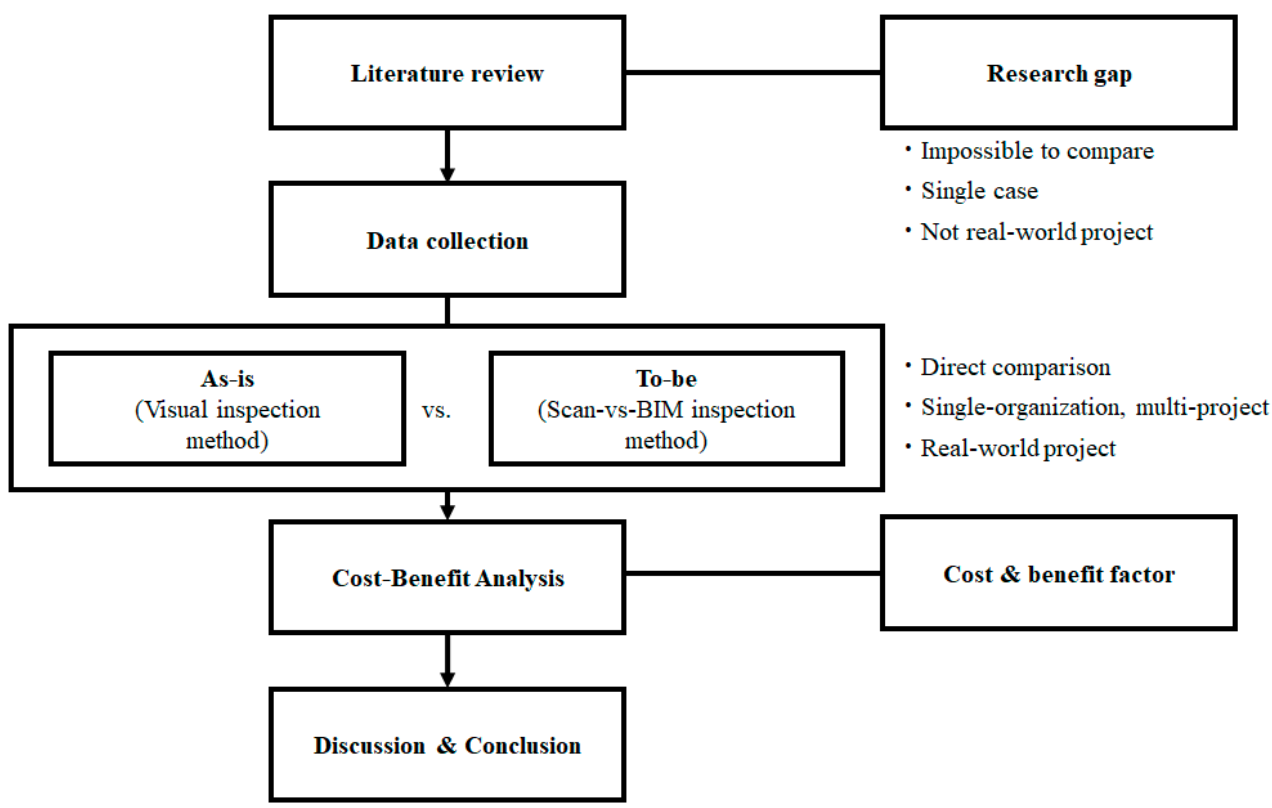
Figure 1. Framework for proving the monetary value of Scan-vs-BIM-based digital transformation.